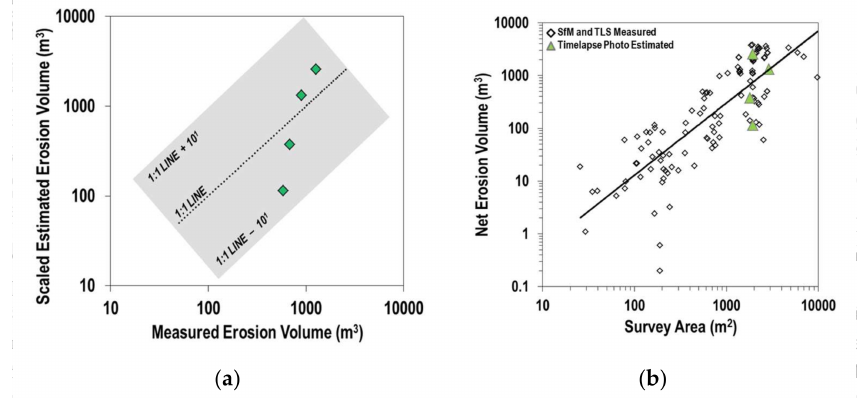
Figure A1. ( a ) Measured bluff erosion from four SfM surveys, 6/15/2014–7/3/2014, 7/3/2014–5/9/2015, 5/9/2015–7/10/2015, and 10/22/2016–5/17/2017, which primarily capture bluff face erosion vs the sum of time lapse photo estimated erosion, using the scaling relation, V = 0.12 A 1.4 . ( b ) Bluff survey area vs net erosion volume for SfM and TLS measured surveys (black diamonds) and time lapse photo estimated areas and volumes (green triangles). Estimated erosion is within the same order of magnitude as SfM-measured erosion for the same time periods.